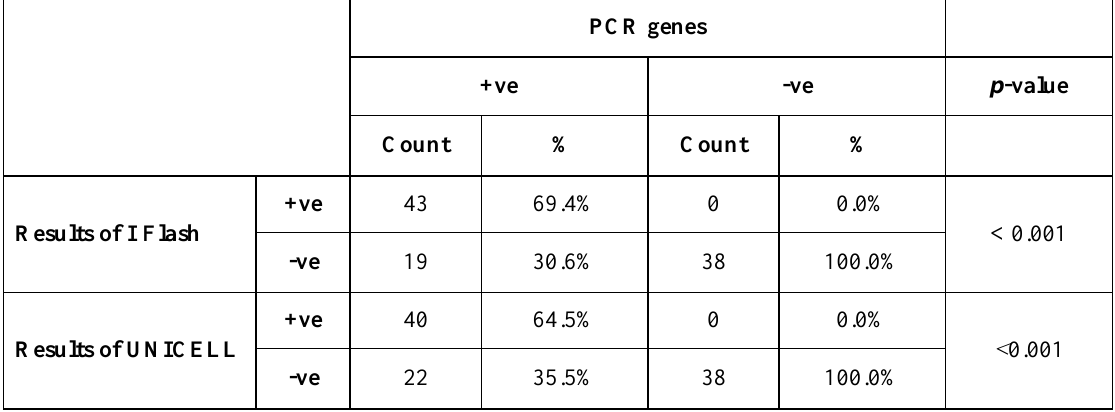
Table 1. Explanation of the results of both I Flash and UNICELL in relation to